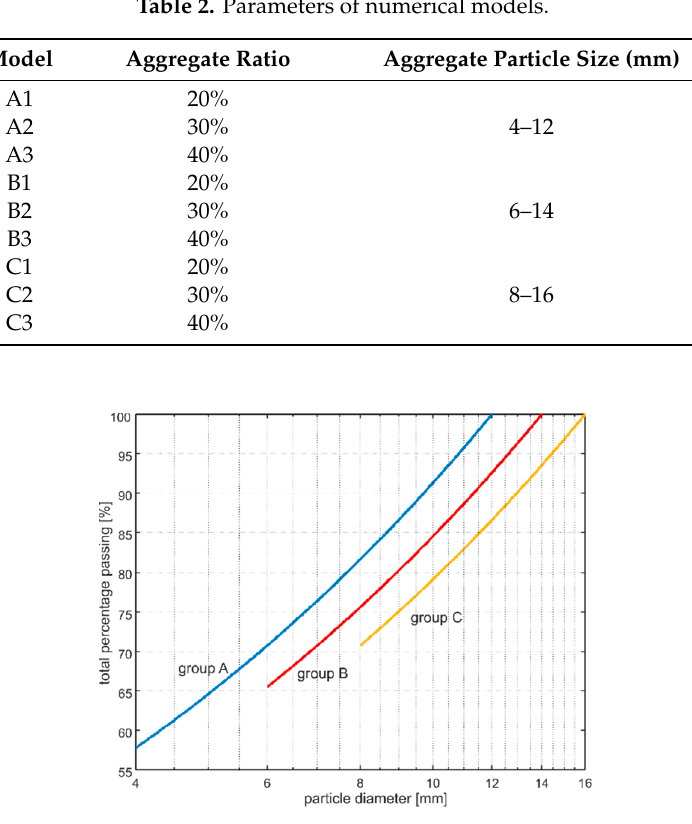
Figure 5. Fuller’s curves for concrete models considered in the study.